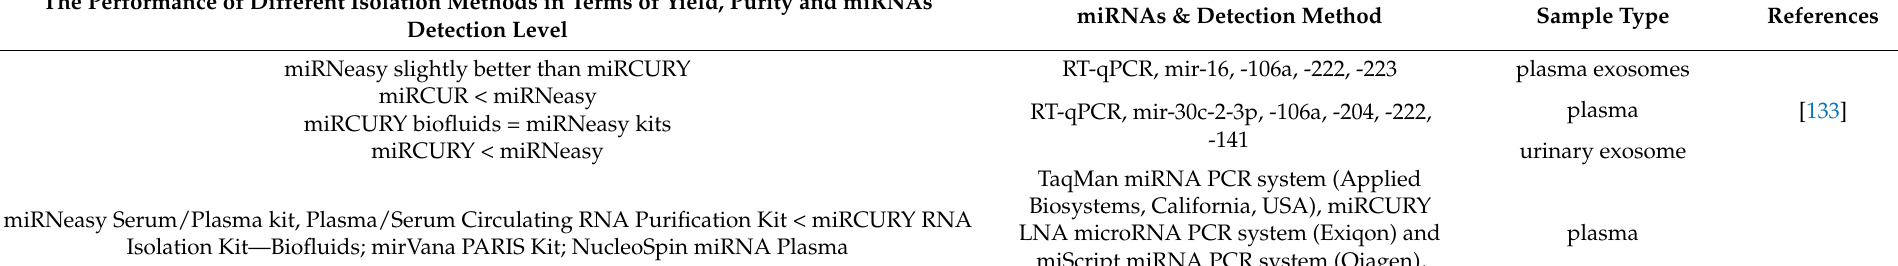
The Performance of Different Isolation Methods in Terms of Yield, Purity and